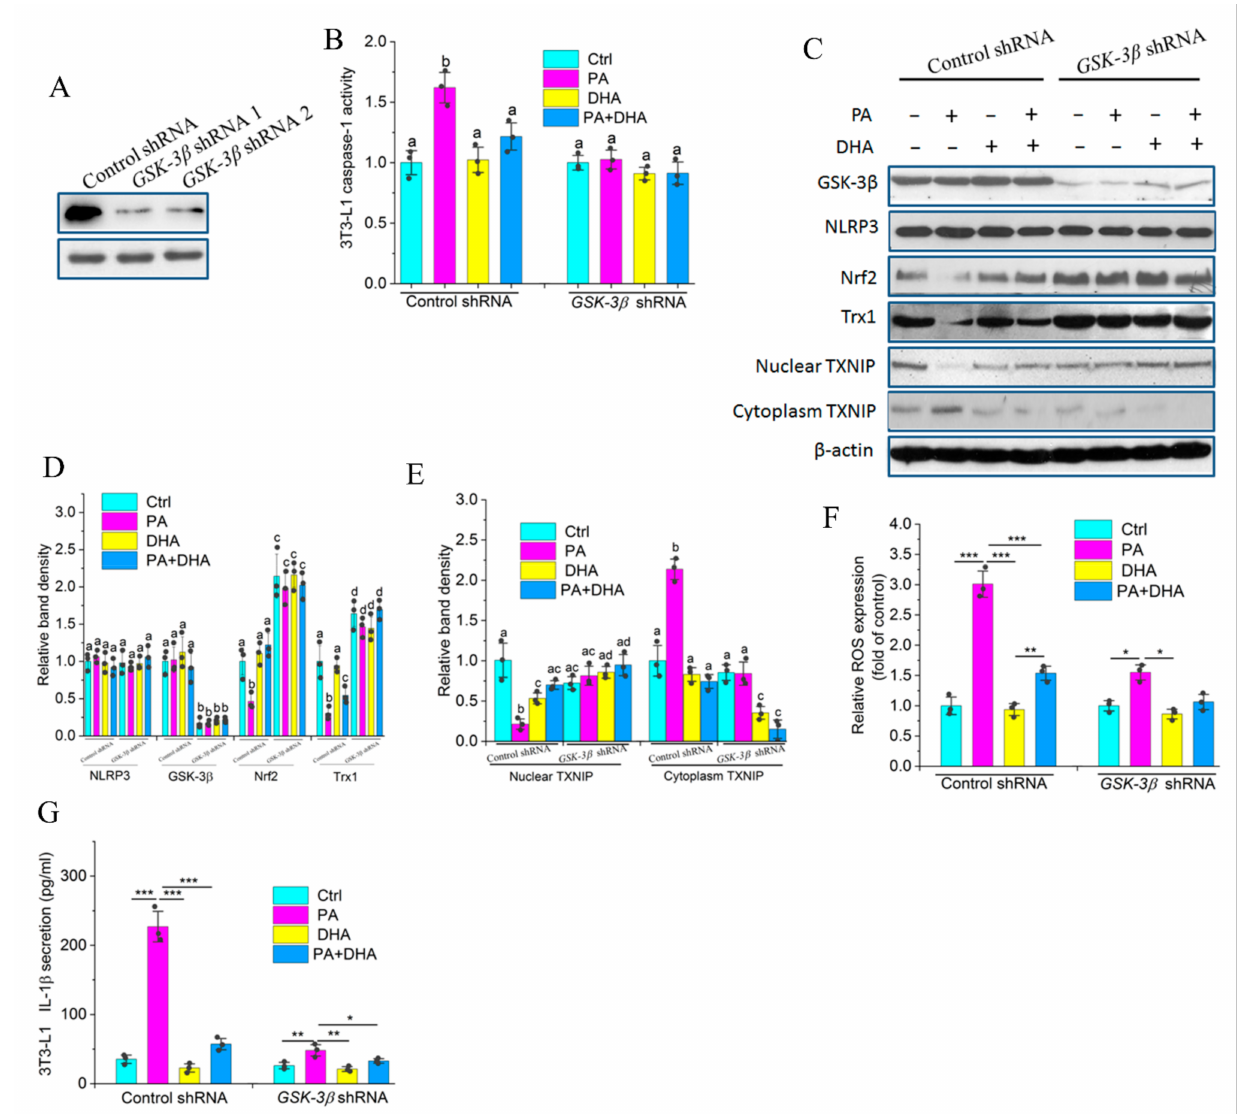
Figure 7. GSk-3 β phosphorylation is indispensable for DHA-mediated inhibition of PA-induced IL-1 β secretion: ( A ) 3T3-L1 preadipocytes were transfected with control shRNA or GSK-3 β shRNA. The protein expression of GSK-3 β was measured by western blotting; ( B ) 3T3-L1 preadipocytes transfected with control shRNA or GSK-3 β shRNA were treated with LPS (10 ng/mL) for 3 h, and then stimulated with PA (250 µ mol/L) or DHA (20 µ mol/L) for 24 h. Caspase-1 activity was determined; ( C ) The cells with the above-mentioned treatment in ( B ) were harvested for the analysis for of NLRP3, Nrf2, Trx1, and TXNIP protein expression; ( D , E ) Band density analysis of western blotting bands in ( C ); ( F ) The cells with the above-mentioned treatment in ( B ) were harvested for analysis of ROS production using the fluoroprobe DCFH-DA; ( G ) The above-mentioned media in ( B ) was used for analysis of IL-1 β secretion by ELISA. Results are presented as mean ± SEM. Means not sharing a common superscript letter are significantly different at * p < 0.05, ** p < 0.01 and *** p <